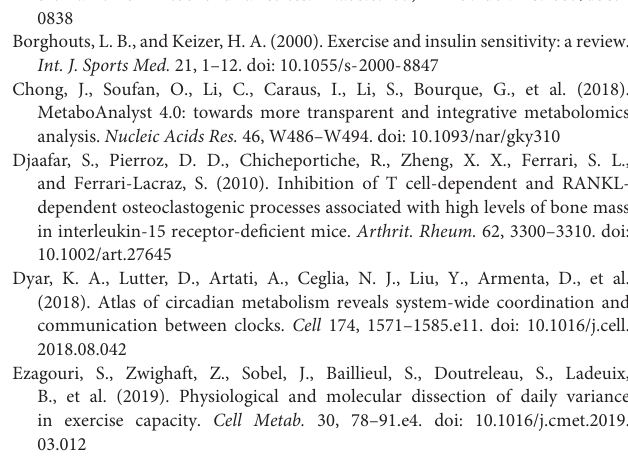
TABLE S1 | Contractile and morphometric measurements of EDL muscles. TABLE S2 | Metabolomics dataset. TABLE S3 | Partial least squares discriminant analysis loadings. TABLE S4 | Partial least squares discriminant analysis VIP